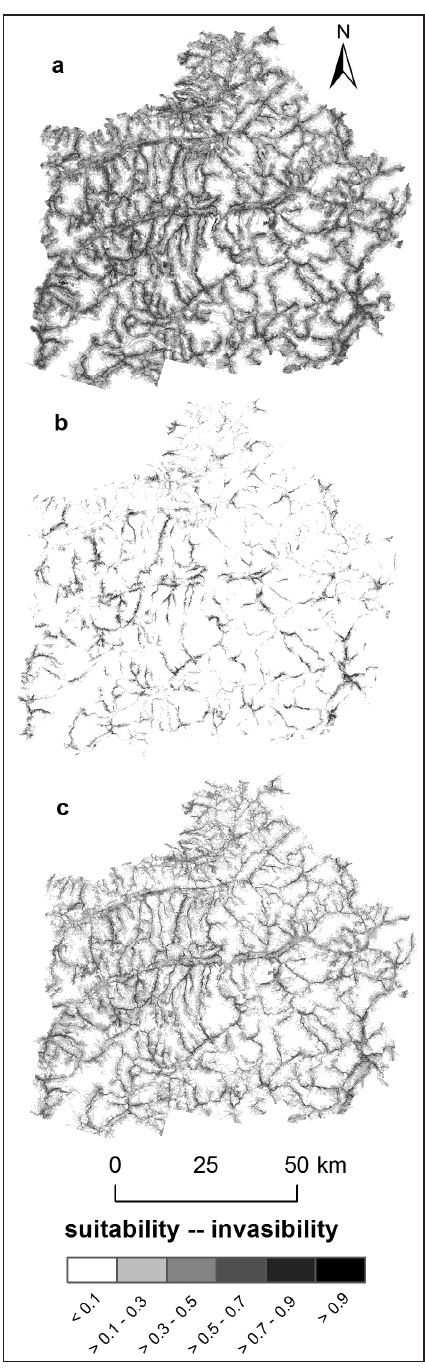
Figure 3. The likely current distribution for a Erigeron annuus and b Asclepias syriaca in our study area. c Shows the invasibility, calculated as the mean probability of occurrence over all eight study